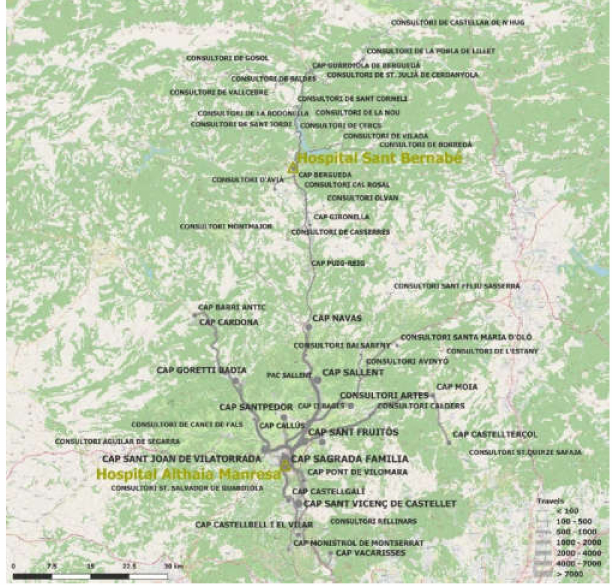
Figure 2. Origin and destination (either Hospital Sant Bernab é in Berga or Althaia Xarxa Assistencial Universit à ria in Manresa) of telemedicine visits avoided. The thickness of the line corresponds to the number of journeys